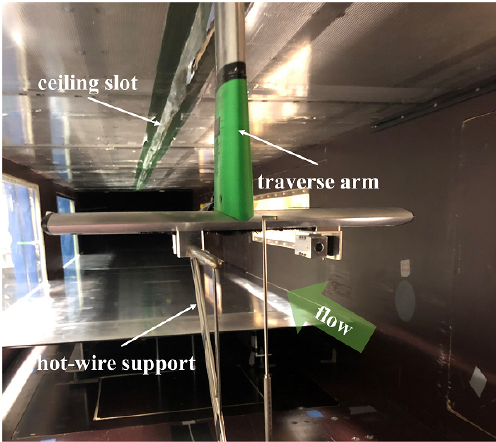
Figure 5. External hot-wire traverse mechanism.